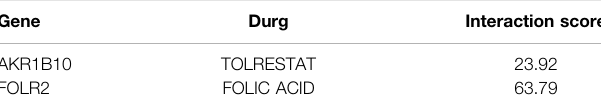
TABLE 1 | Drug-gene interaction analysis of the top 20 most signi fi cant DEGs (Interaction score > 20). Gene Durg